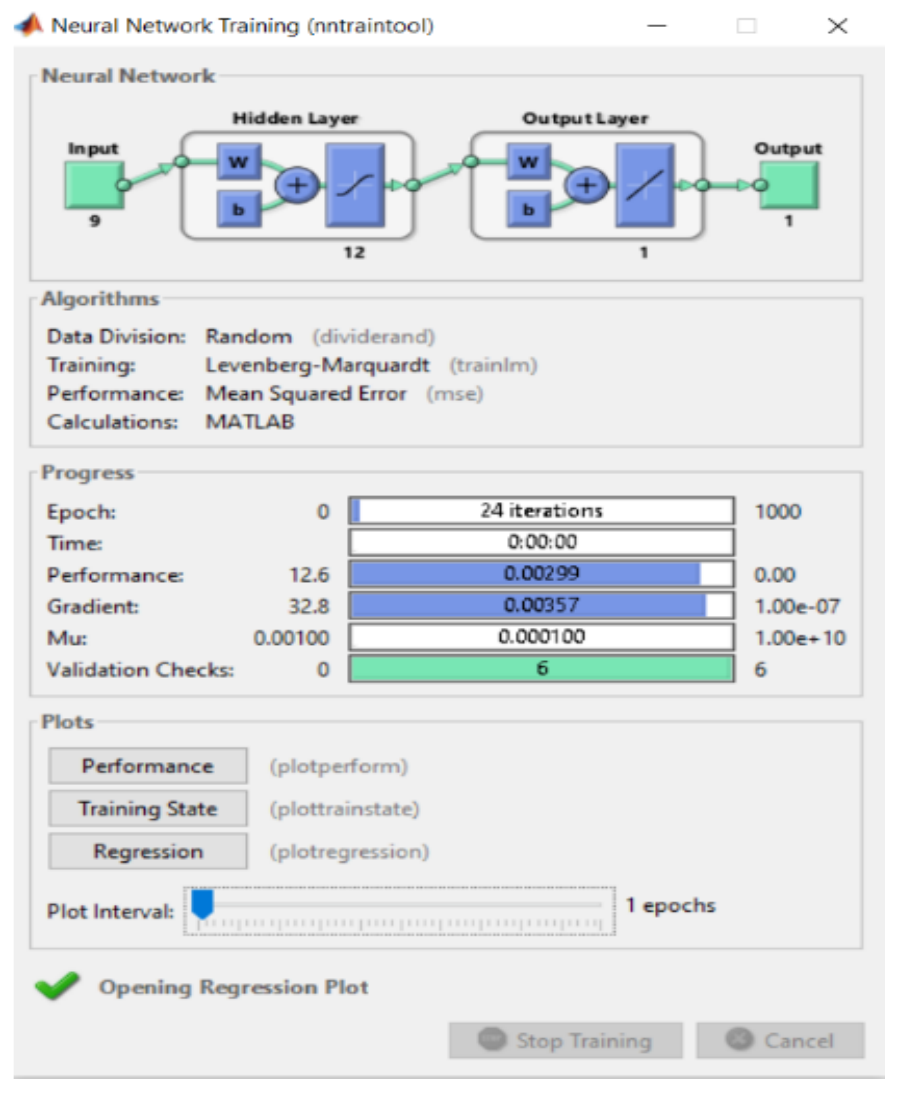
Figure 2. Structure of the neural network employed in this study. The entire training process took 18 iterations, and the performance was 0.0031481. The training process is shown in the Figure 3.